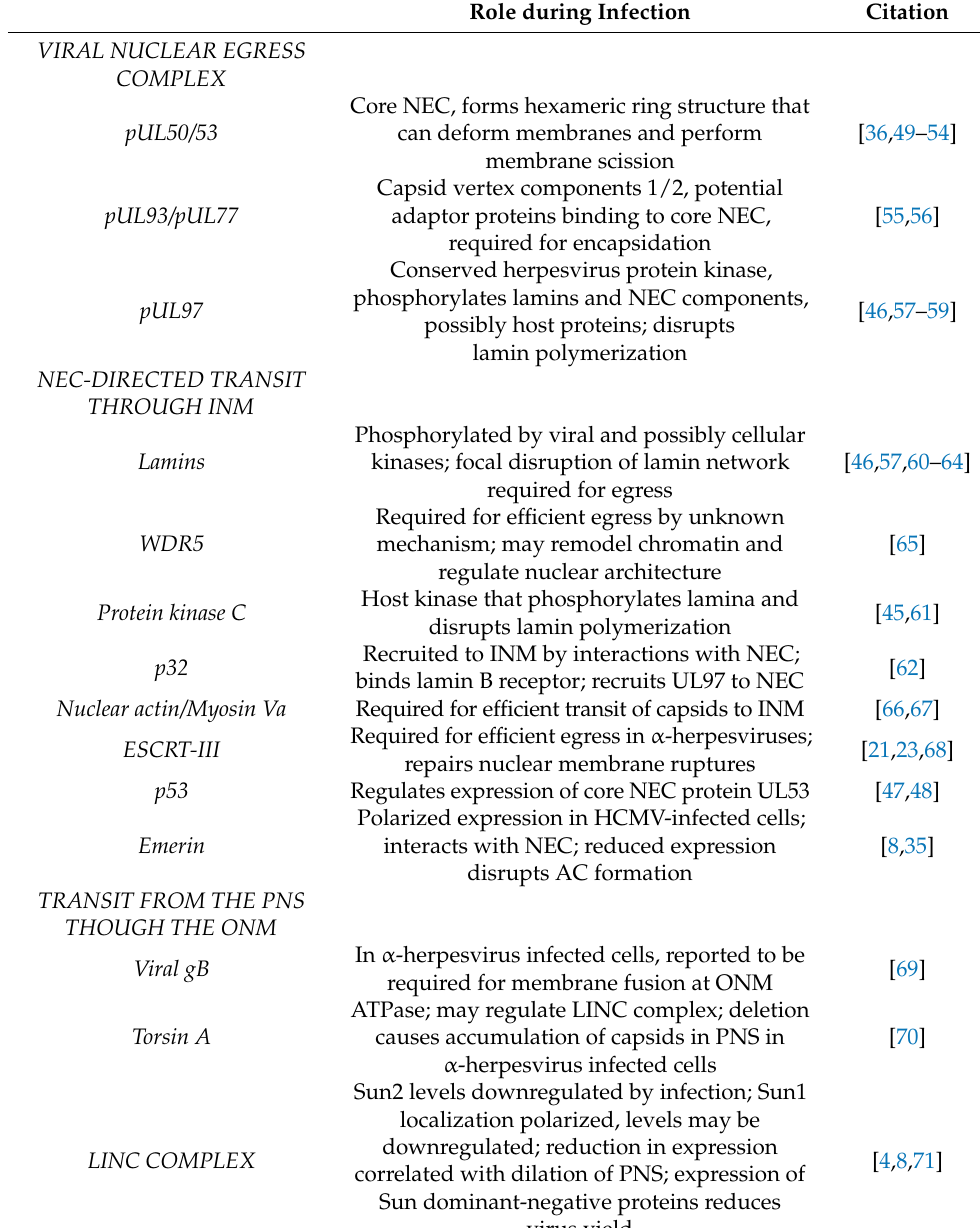
Table 1. Viral and cellular factors involved in nuclear